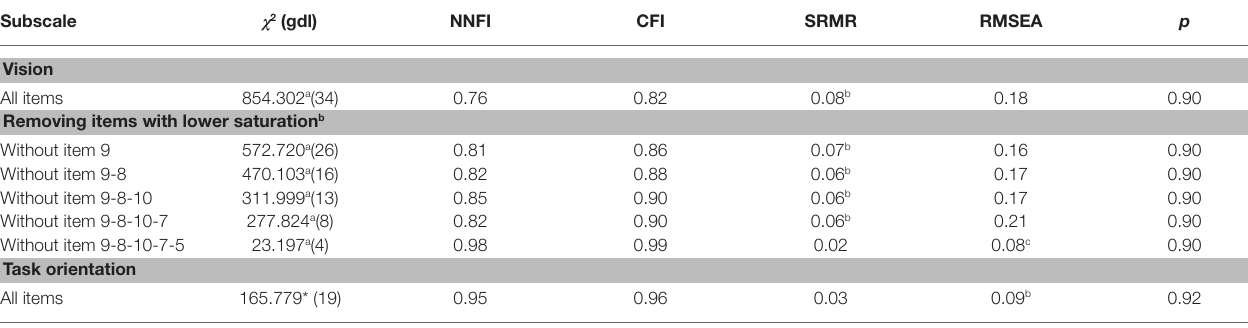
TABLE 4 | Fit indices – “vision” and “task orientation” subscales.